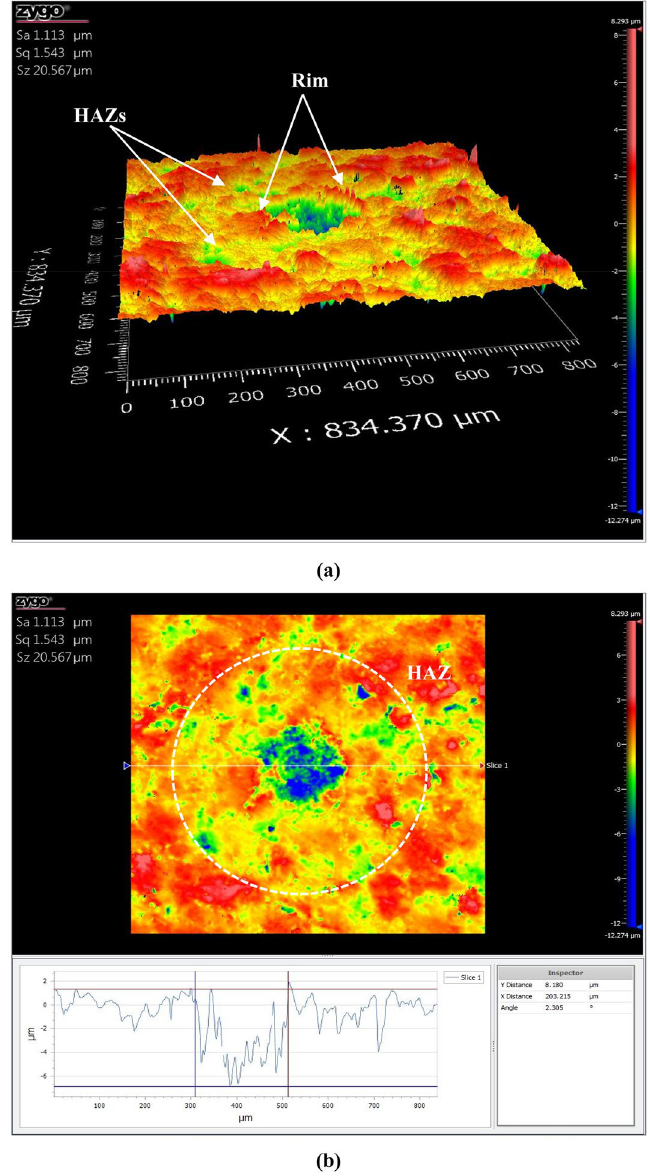
Figure 8. 3D surface profilometer of coal sample after ablation by ns-Chem system: ( a ) is the 3D profile and ( b ) is surface profile view. The ablated volume can be simulated as a truncate-cone structure with clear thermal effects; rims and heat affected zones (HAZs). The crater diameter is 203 μm and its depth is 8 μm.